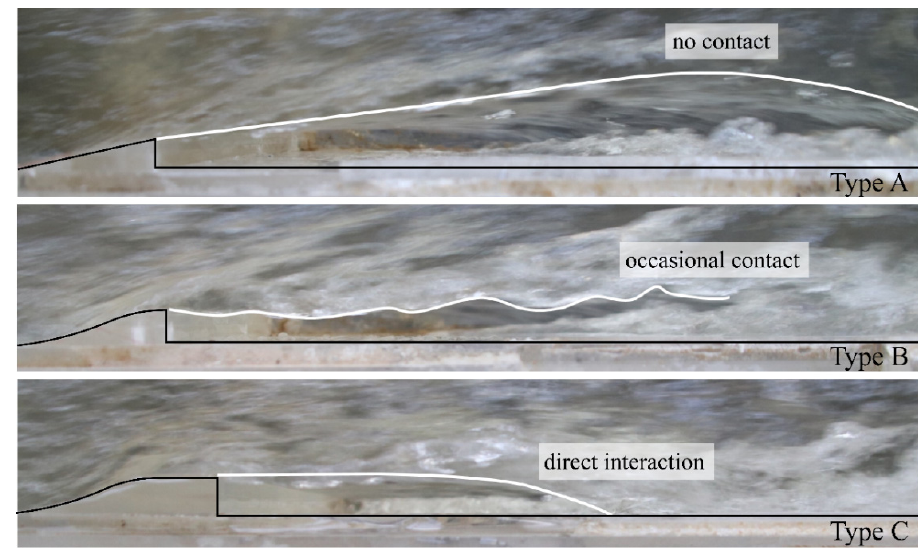
Figure 5. Top view of the flow pattern near the lateral cavity.